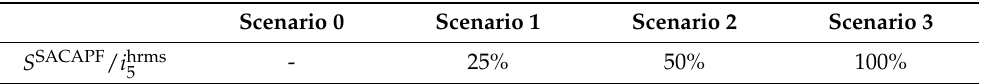
Table 3. Ratio of the rating of the SACAPF to the harmonic content of the nonlinear load.